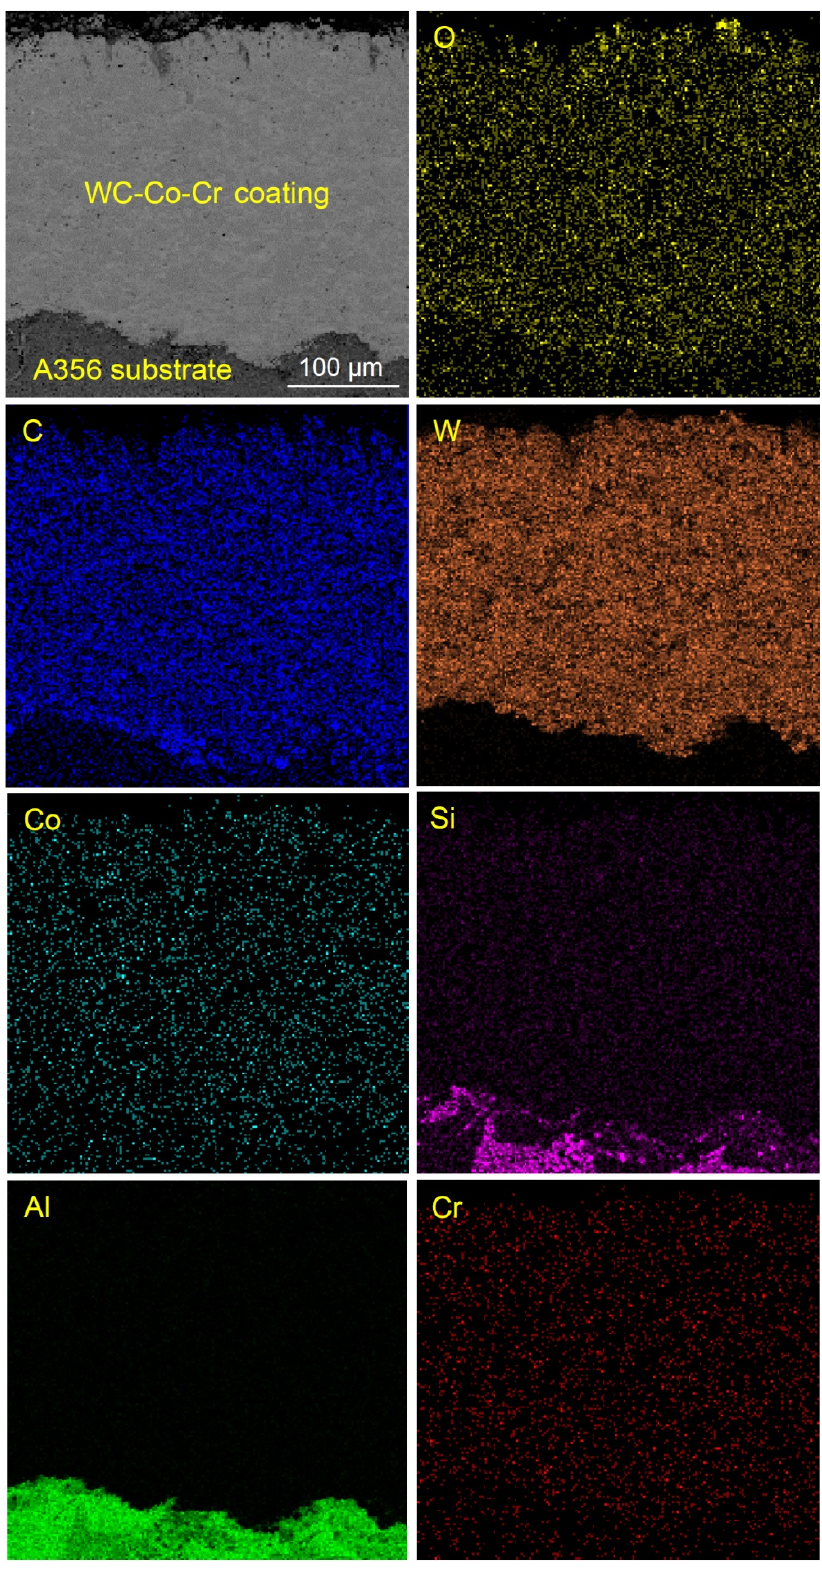
Figure 4. EDS elemental mapping on the cross-section of HVOF-sprayed WC-Co-Cr coating on A356 substrate.